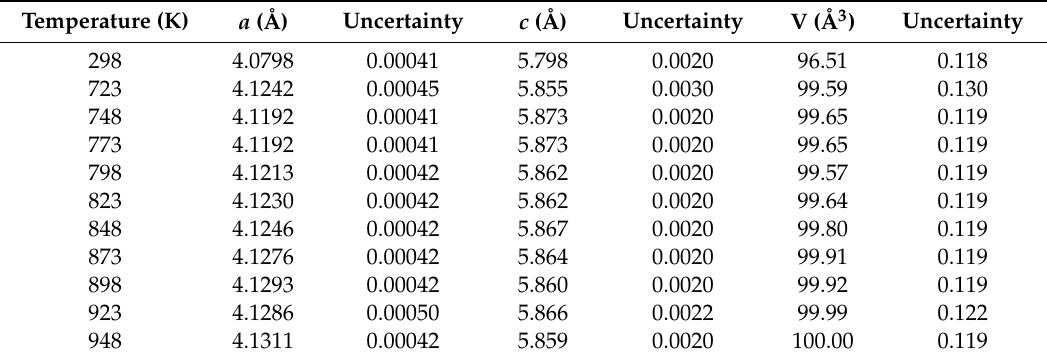
Table 2. Measured lattice parameters and volumes for γ -LaOF at 298 K, and from 723 K to 948 K. Temperature (K)